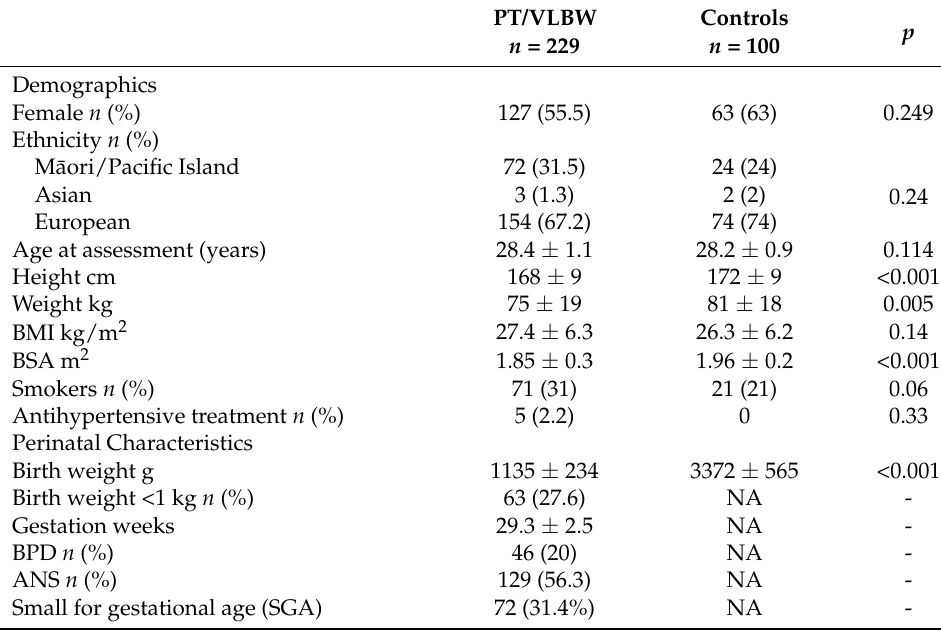
Table 1. Demographics and Perinatal